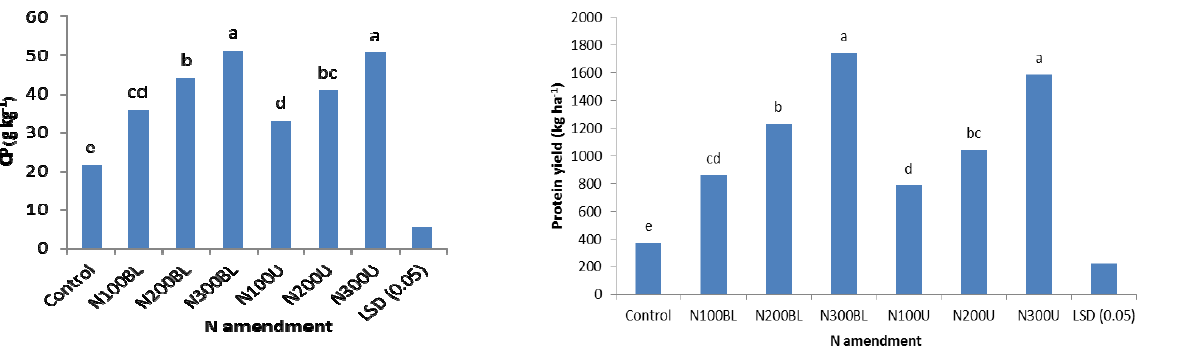
Fig. 8. The effects of N source and rate on crude protein (CP) concentration of silage corn. Means with the different letters show significant difference (LSD, P ≤ 0.05). See Fig. 2 for abbreviations